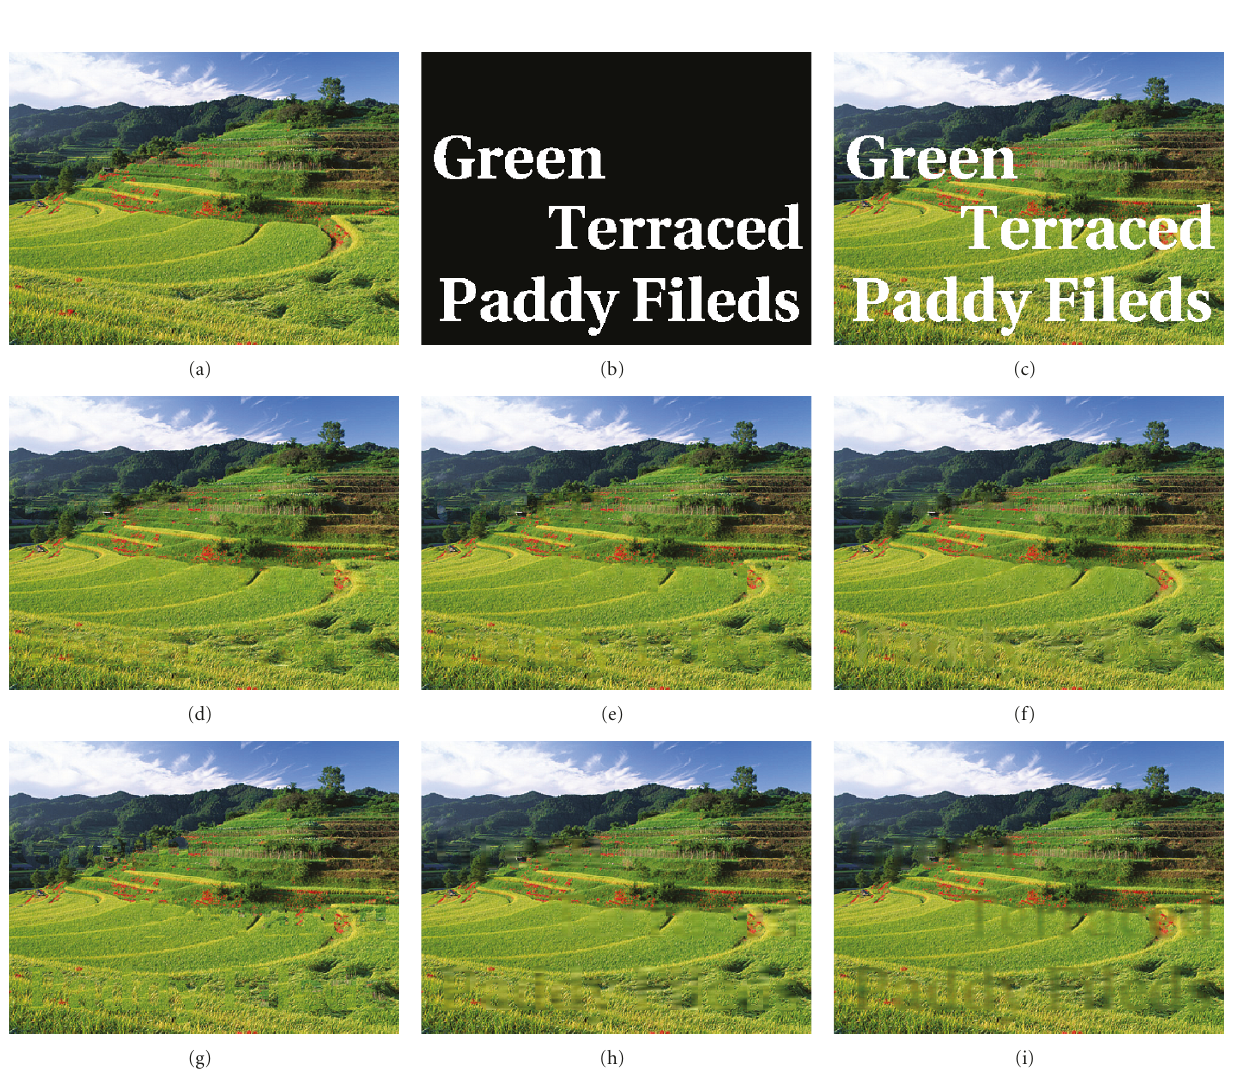
Figure 6: (a) Original image (480 × 360 pixels, 24-bit color levels). (b) Flag image whose white regions correspond to missing areas. (c) Corrupted image including text regions (11.9% loss). (d) Reconstructed image by the proposed method. (e) Reconstructed image by the method based on the random selection. (f) Reconstructed image by the method which utilizes the MSE instead of the SSIM index. (g) Reconstructed image by the conventional method [11]. (h) Reconstructed image by the conventional method [13]. (i) Reconstructed image by the conventional method